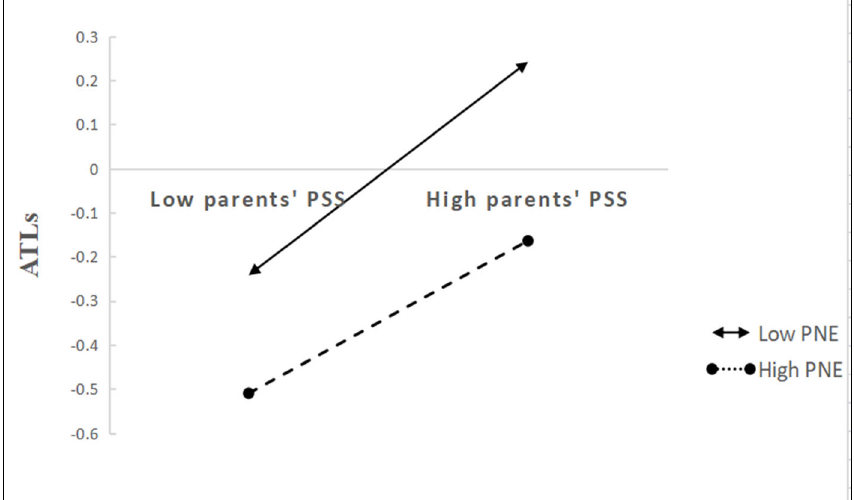
Figure 3. The interaction between parents’ PSS and PNE on preschool children’s ATLs. Parents’ PSS = Parents’ perceived social support, PNE = Parental negative emotion, ATLs = Children’s approaches to learning.